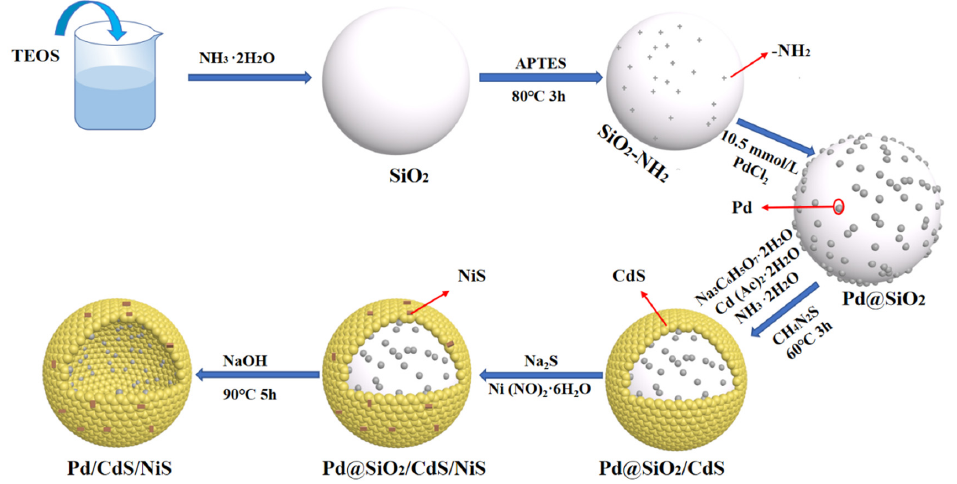
Figure 1. Schematic illustration of the synthesis process Pd/CdS/NiS